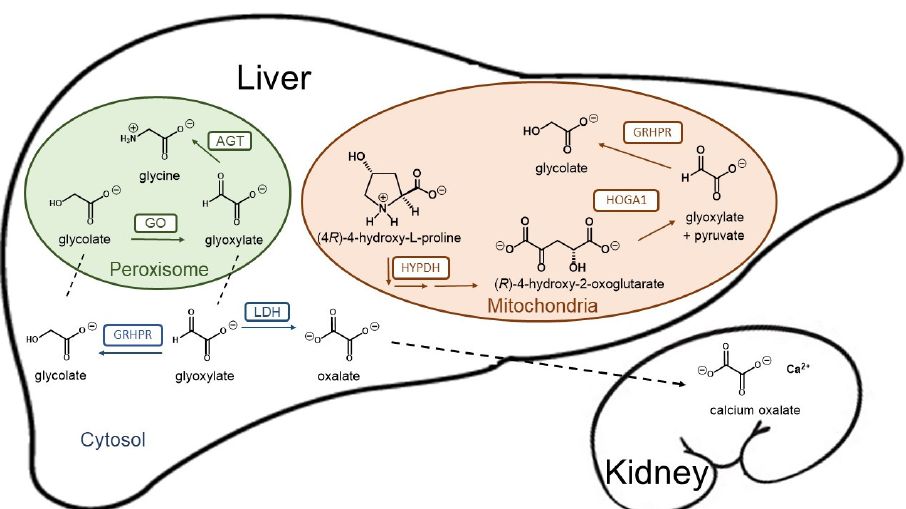
Figure 1. Schematic representation of the hepatic glyoxylate metabolism and calcium oxalate formation. Glyoxylate is a very reactive aldehyde produced in the intermediary metabolism of glycine,